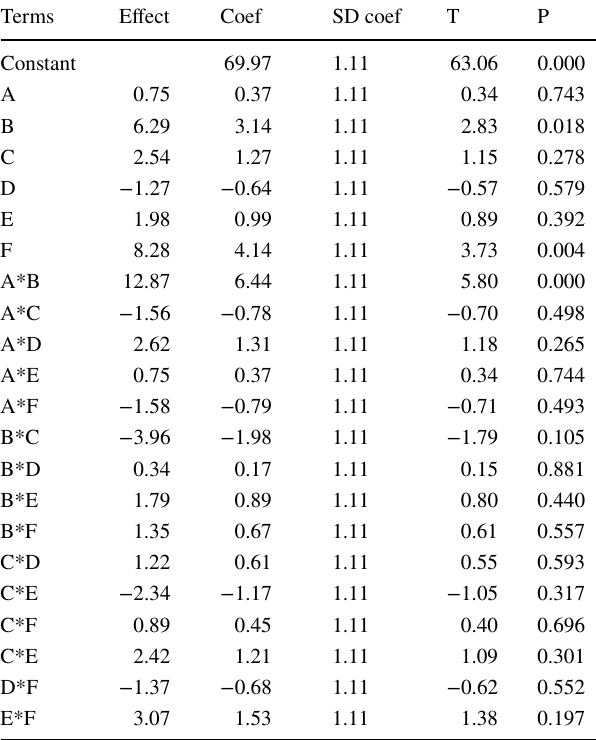
Table 8 Estimated effects and coefficients for % E of Cd(II) after